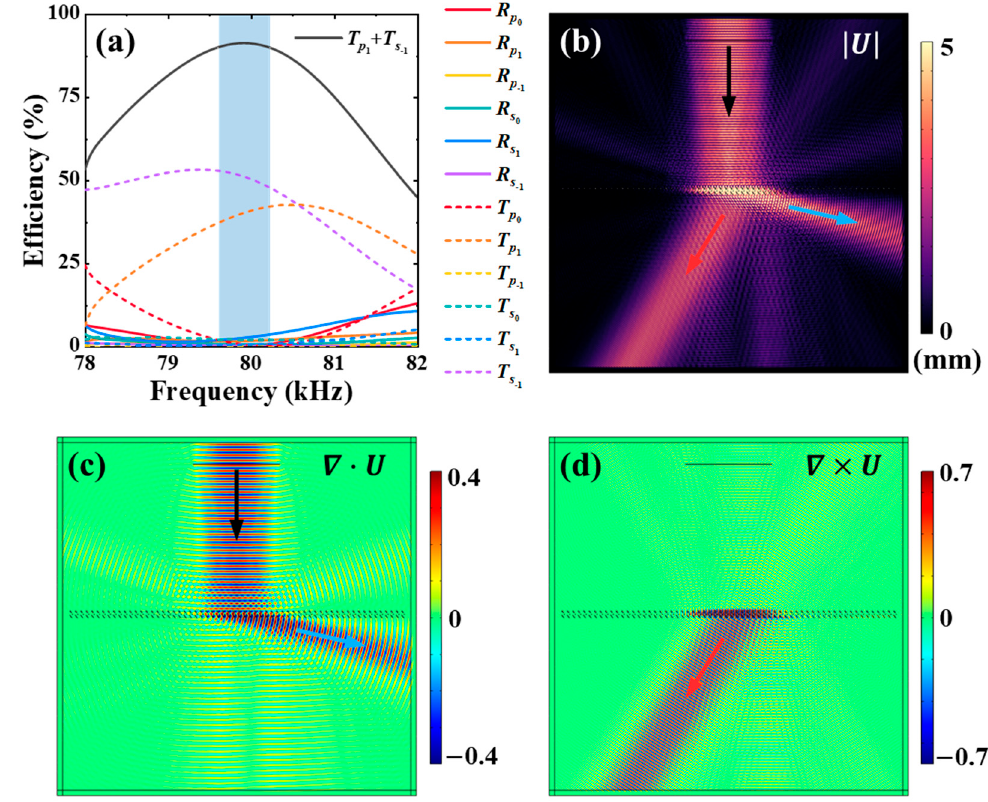
Figure 5. High-efficiency transmission along the T p and T s channels when a p -wave is normally incident on the metagrating. ( a ) The diffraction efficiency spectra for all 12 channels, where f 0 = 80 kHz is the operating frequency; ( b ) shows the amplitude of displacement amplitude at f 0 ; ( c , d ) show the divergence and curl of the displacement field, corresponding to longitudinal and transverse wave components, respectively. Black, blue and red arrows represent the incident p -wave, transmitted p -wave, and transmitted s -wave, respectively.